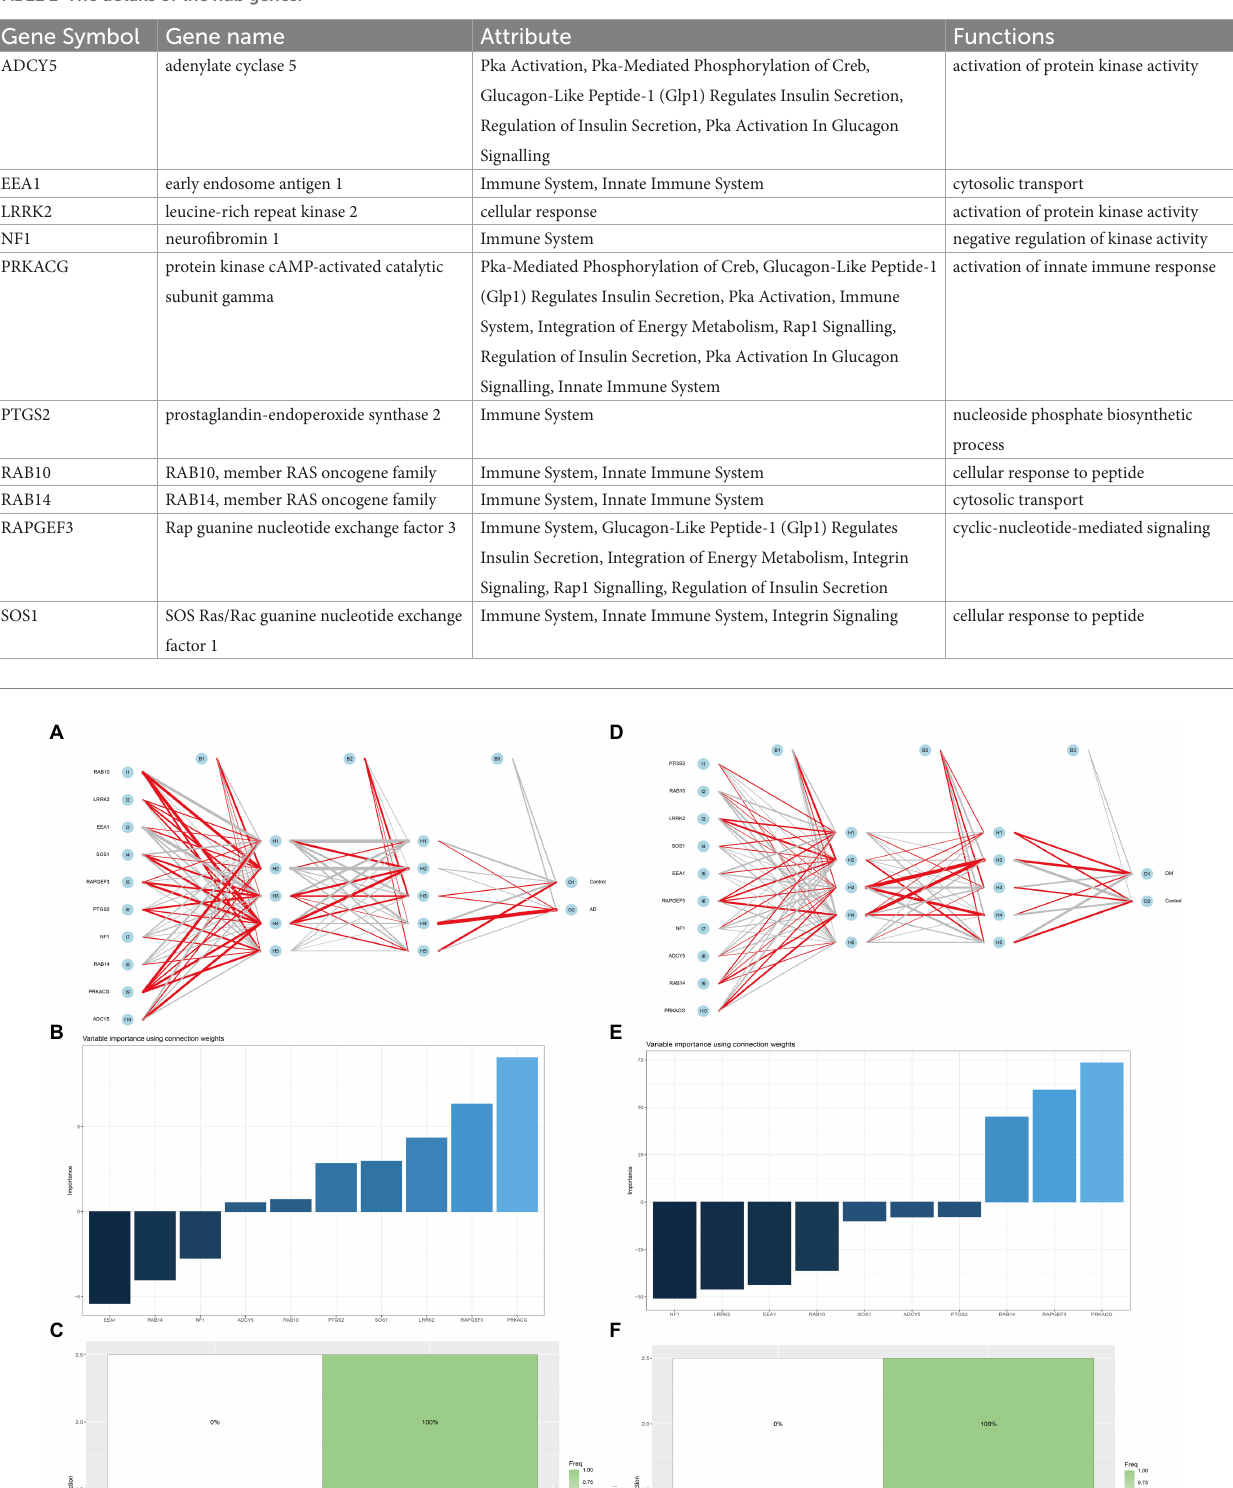
TABLE 1 The details of the hub genes.